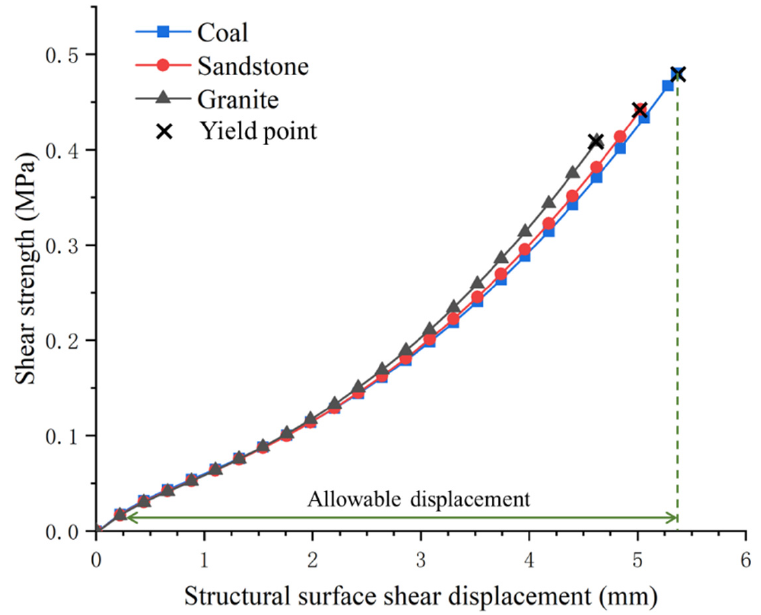
Figure 19. Schematic diagram of the allowable displacement of the anchored structural surface.